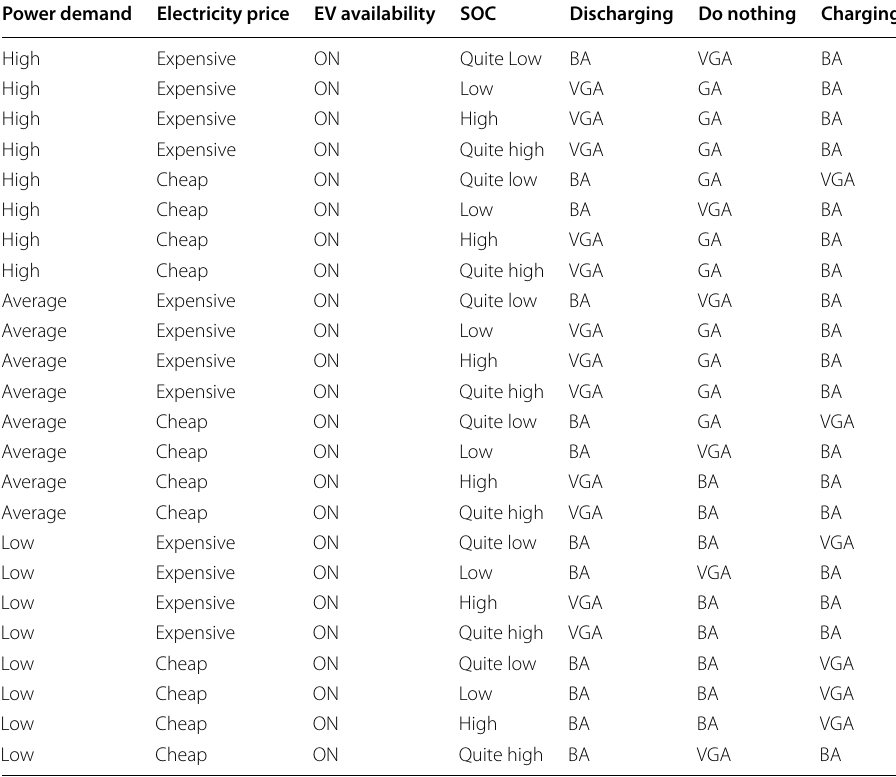
Table 4 PEV management fuzzy logic controller knowledge base